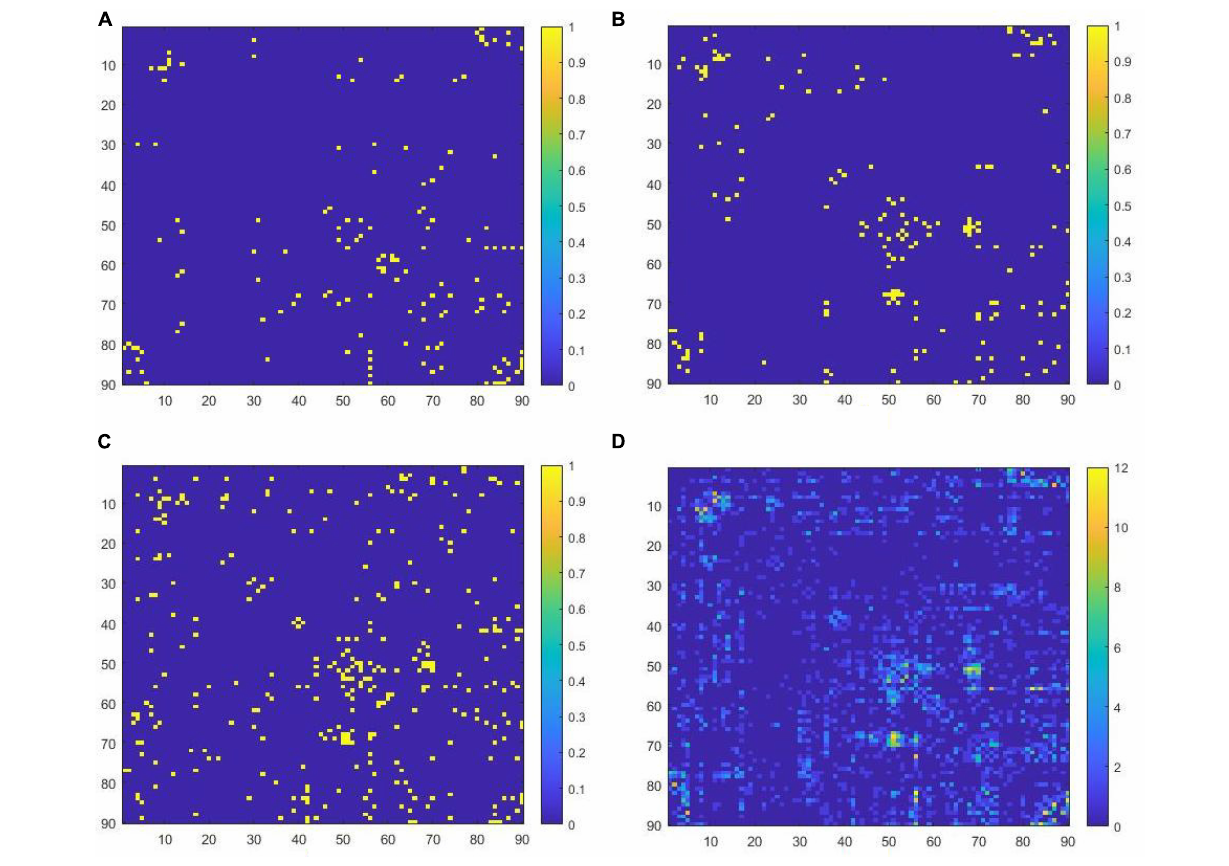
Training accuracy Validation (%) accuracy